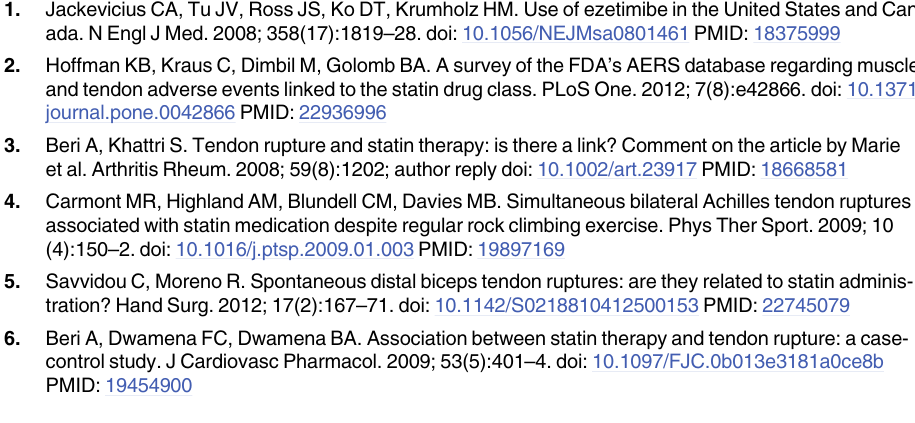
means ± 95% confidence interval (CI). Individual donor-specific cell lines are represented by dots. S2 Fig. Gene expression analysis: Effect of treatment on GAPDH, heat shock proteins and tendon related genes. The gene expression after 1 or 7 days of statin treatment presented as the absolute values in arbitrary units (A.U.), which is a ratio between the mRNA and the housekeeping mRNA (RPLP0). Data is presented on a logarithmic y scale and the line repre- sents the mean value. Individual donor-specific cell lines are represented by different symbols. Low dose (L) statin treatment corresponds to 0.05μM of either simvastatin or atorvastatin and high dose (H) corresponds to 0.5μM. S3 Fig. Gene expression analysis: Effect of treatment on collagen, MMPs and TIMP-1. The gene expression after 1 or 7 days of statin treatment presented as the absolute values in arbi- trary units (A.U.), which is a ratio between the mRNA and the housekeeping mRNA (RPLP0). Data is presented on a logarithmic y scale and the line represents the mean value. Individual donor-specific cell lines are represented by different symbols. Low dose (L) statin treatment corresponds to 0.05μM of either simvastatin or atorvastatin and high dose (H) corresponds to 0.5μM. Significant changes from DMSO-control are indicated by (cid:3) (p < 0.05), (cid:3)(cid:3) (p < 0.01), and (cid:3)(cid:3)(cid:3) (p < 0.001).